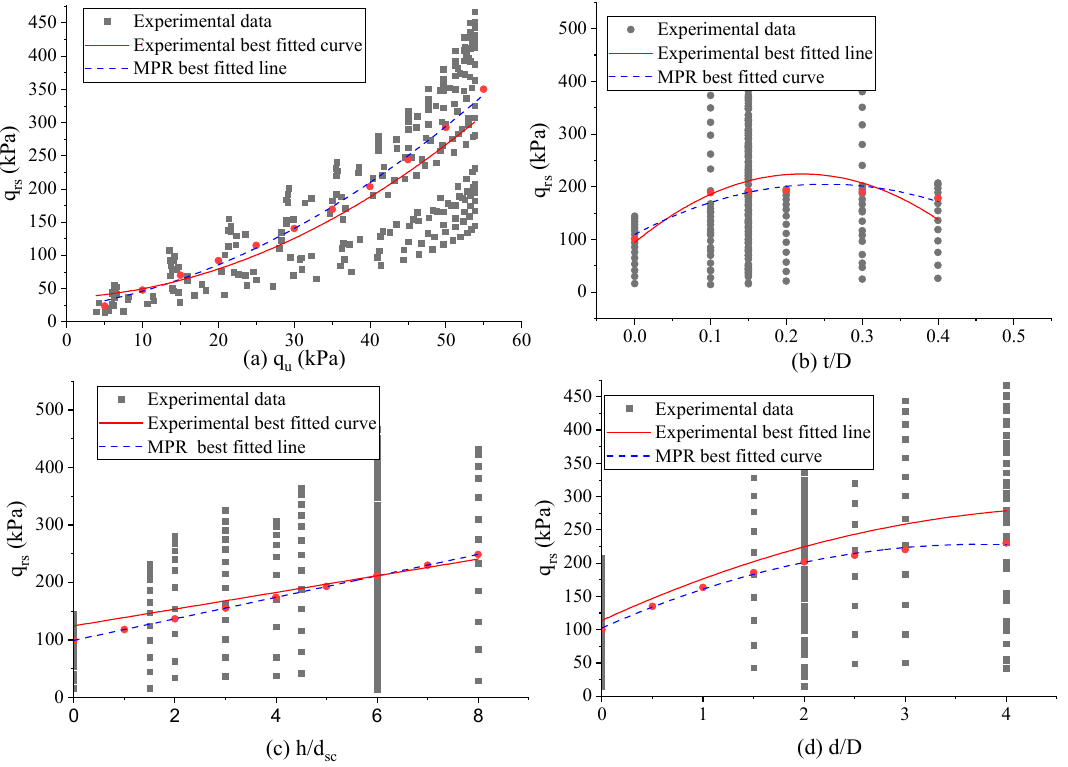
Figure 6. Comparison of the best-fit curves for bearing capacity ( q rs ) based on input features: ( a ) q u , ( b ) t / D , ( c ) h / d sc , and ( d ) d / D , with experimental values and the model predictions from MPR.